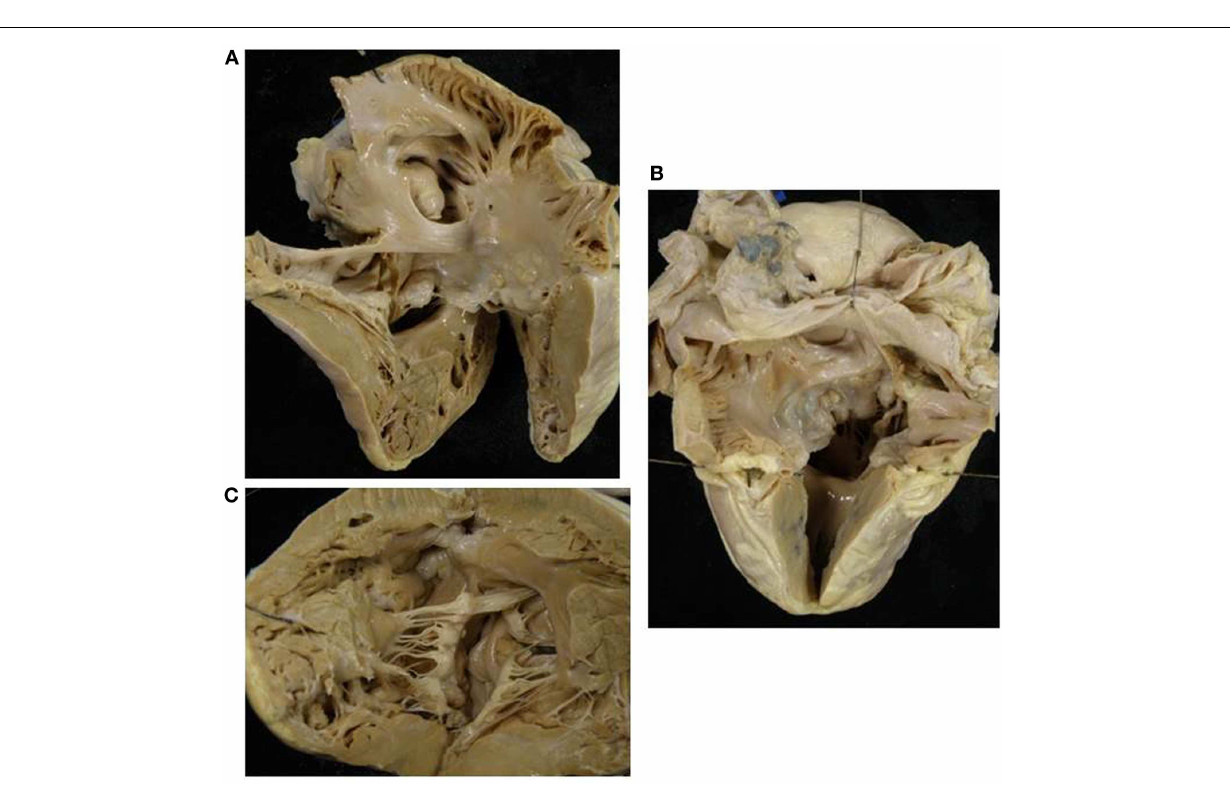
FIGURE 6 | Double inlet–outlet right ventricle . (A) View of the right-sided cardiac chambers: a common atrioventricular valve is present and drains the blood from both atria, predominantly into an anterior ventricular chamber of right morphology. (B) View of the left-sided cardiac chambers: note the